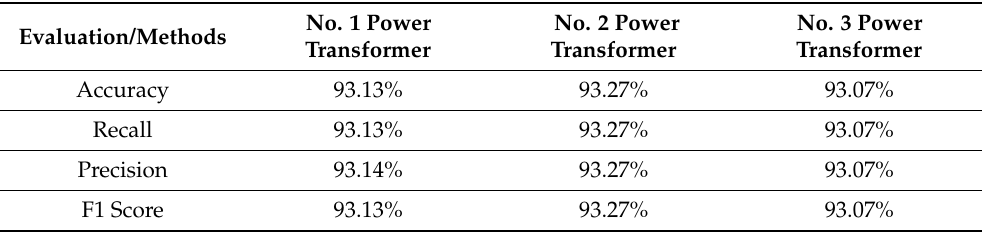
Table 5. Evaluation results of our proposed semi-supervised transfer learning models after training on the raw target datasets without unlabelled